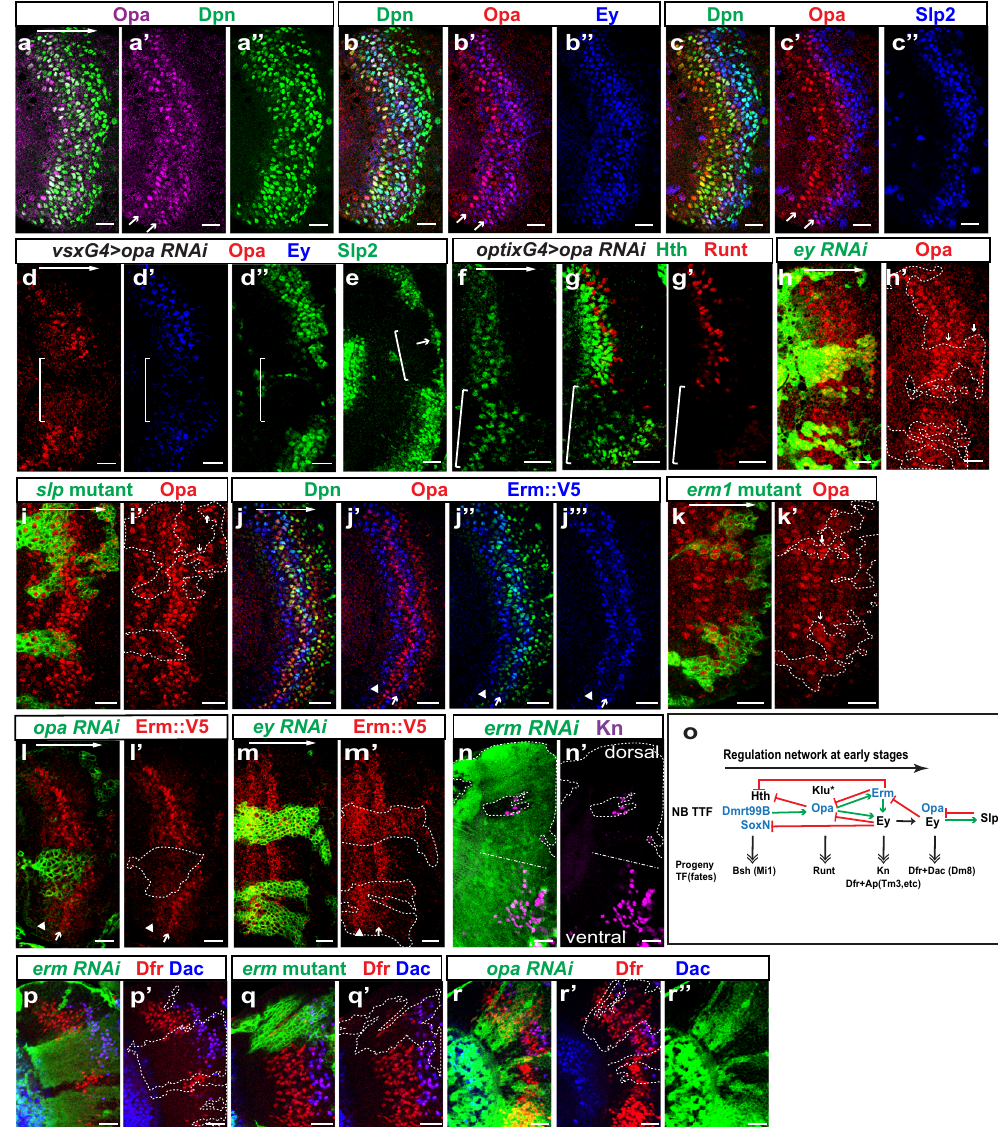
Fig. 3 Opa and Erm are among the early TTFs. a – a ” Opa protein (magenta) is expressed in two stripes of NBs (marked by Dpn in green). b − b ” The fi rst stripe of Opa (red) is downregulated as Ey (blue) is upregulated while the second stripe of Opa overlaps with the Ey stripe in NBs (marked by Dpn in green). c – c ” The second stripe of Opa (red) is downregulated as Slp (blue) is upregulated in NBs (marked by Dpn in green). d – d ” When opa-RNAi is driven by vsxGal4 , Opa (red) is lost in the center domain (cOPC, white bracket), Ey (blue), and Slp2 (green) are also mostly lost in the same domain (in 11 out of 11 brains). e At a slightly deeper focal plane in a vsxGal4 > opa-RNAi brain where we can see the oldest NBs, delayed activation of Slp2 (green) can be observed (in 8 out of 11 brains). f – g ’ opa-RNAi is driven by optixGal4 in mOPC indicated by a white bracket (only one side of mOPC is shown in this image). f At a surface focal plane, Hth (green) is expanded into older NBs in mOPC (in three out of three brains). g , g ’ At a deeper progeny focal plane, Hth expression (green) is expanded into the later-born progeny, and Runt (red) expressing neurons are lost (in three out of three brains). h , h ’ In ey-RNAi clones marked by GFP (green), Opa expression (red) is de-repressed in the gap and also expanded into older NBs (in 15 out of 15 clones). i , i ’ In slp mutant clones marked by GFP (green), Opa expression (red) is expanded into older NBs (white arrows) (in eight out of eight clones). j – j ”’ Erm::V5 protein (blue) is expressed in two stripes, one before the NB (marked by Dpn in green) formation (arrowhead), and the other (white arrow) is between the two Opa stripes (red). k , k ’ In erm 1 mutant clones marked by GFP (green), Opa expression (red) is de-repressed in the gap (white arrows) (in 13 out of 13 clones). l , l ’ In opa-RNAi clones marked by GFP (green), Erm::V5 expression (red) is lost in NBs (in nine out of nine clones). m , m ’ In ey-RNAi clones marked by GFP (green), Erm::V5 expression (red) is expanded into older NBs (in 14 out of 14 clones), but the level is lower than that of the wild-type part of the Erm stripe. n , n ’ In erm-RNAi clones marked by GFP (green), Kn (magenta) expressing neurons are lost on the dorsal side (in 15 out of 15 clones), but still present on the ventral side (in 13 out of 14 clones). A white dashed line separates the dorsal vs. ventral side. o A schematic showing the regulatory network among early TTFs and the neuron fates generated at each stage. p , p ’ In erm-RNAi clones marked by GFP (green), neurons expressing Dfr (red) but not Dac (blue) are lost, and the remaining neurons express both Dfr and Dac thus appear purple (in 13 out of 15 clones). q , q ’ In erm 1 mutant clones marked by GFP (green), neurons expressing Dfr (red) but not Dac (blue) are lost, and the remaining neurons expressing both Dfr and Dac thus appear purple (in 11 out of 13 clones). r – r ” In opa-RNAi clones marked by GFP (green), neurons expressing both Dfr (red) and Dac (blue) are lost, but neurons expressing only Dfr are expanded (in eight out of eight clones). Scale bars: 20 μ